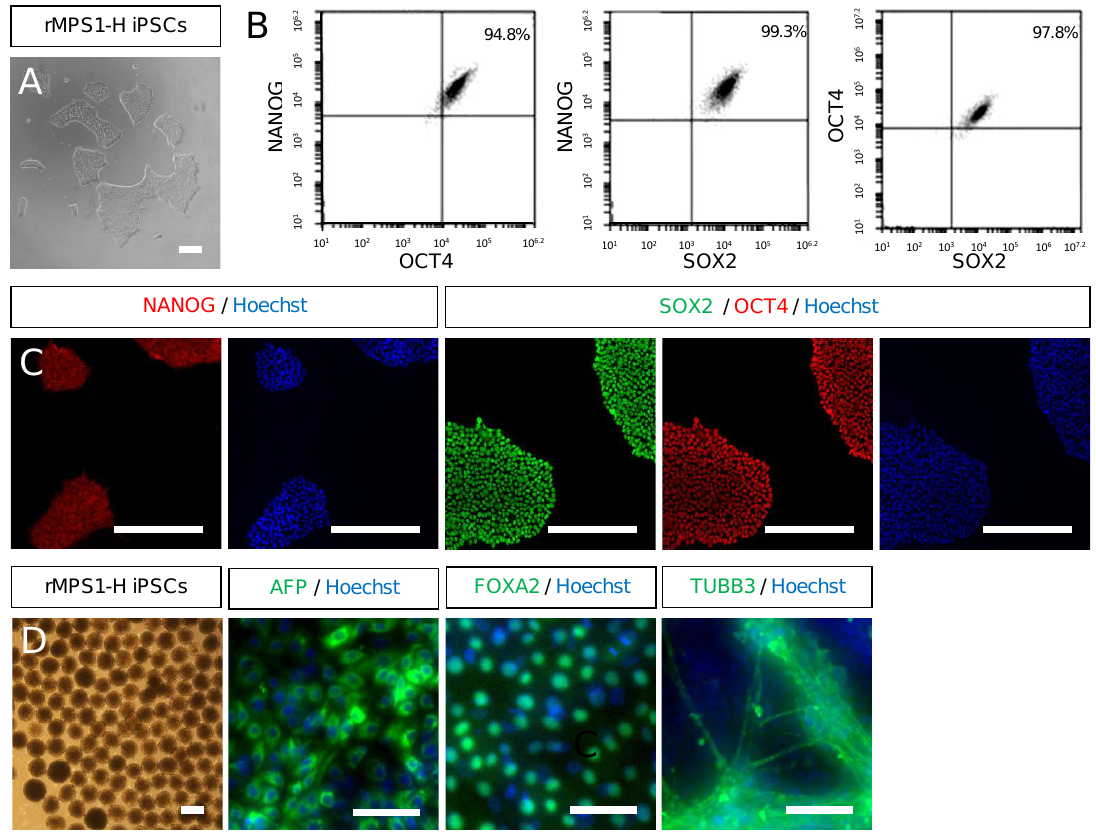
Figure 2. Characterization of rescued MPS1-H iPSC line. ( A ) Rescued MPS1-H iPSC line exhibits morphological aspects of pluripotent stem cells. ( B ) FACS analysis and ( C ) immunofluorescence staining confirm the expression of pluripotent markers NANOG, SOX2 and OCT4. Nuclei was counterstained with Hoechst. ( D ) Validation of the di ff erentiation potential of rMPS1-H iPSC line by immunofluorescence staining of spontaneously di ff erentiated embryoid bodies into the three germ layers: endoderm (AFP), mesoderm (FOXA2), and ectoderm (TUBB3). Nuclei was counterstained with Hoechst. All scale bars = 50 µ